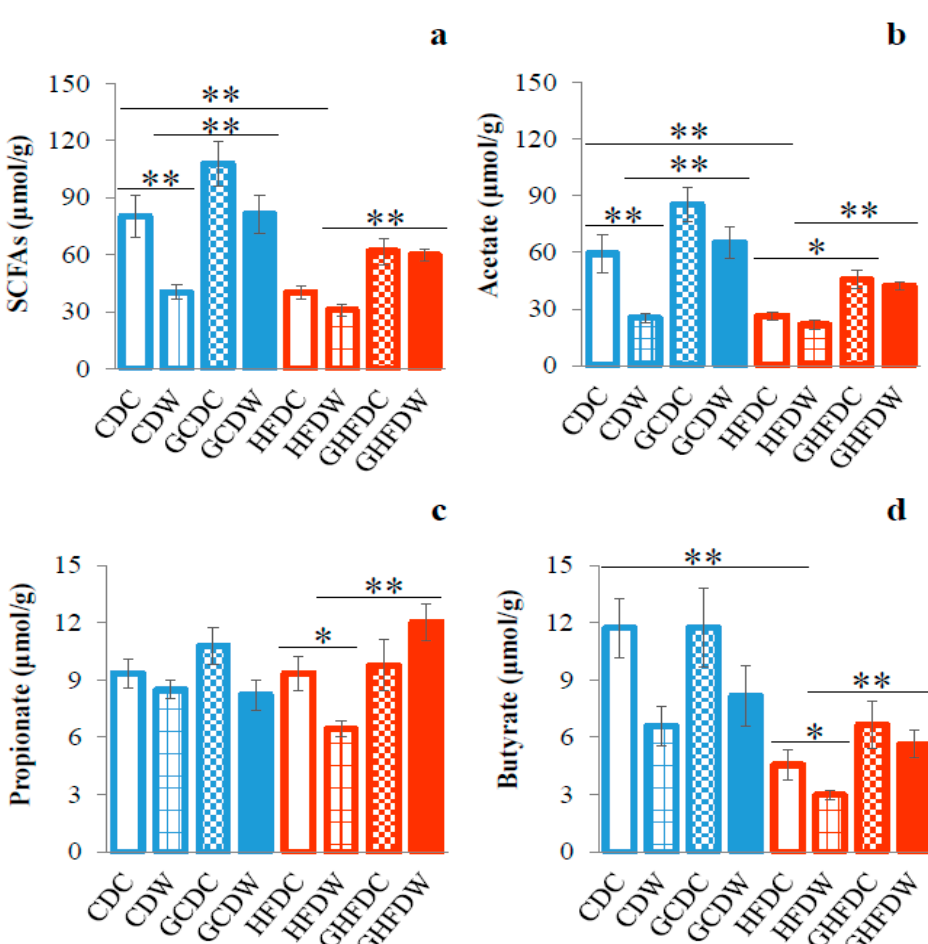
Figure 7. The supplemental effect of wheel running on cecum SCFAs in PHGG intake mice under CD and HFD feeding. The total SCFAs ( a ), acetate ( b ), propionate ( c ), and butyrate ( d ) contents in cecum were shown. The values were expressed as the mean ± S.E.M. * p < 0.05 and ** p < 0.01.